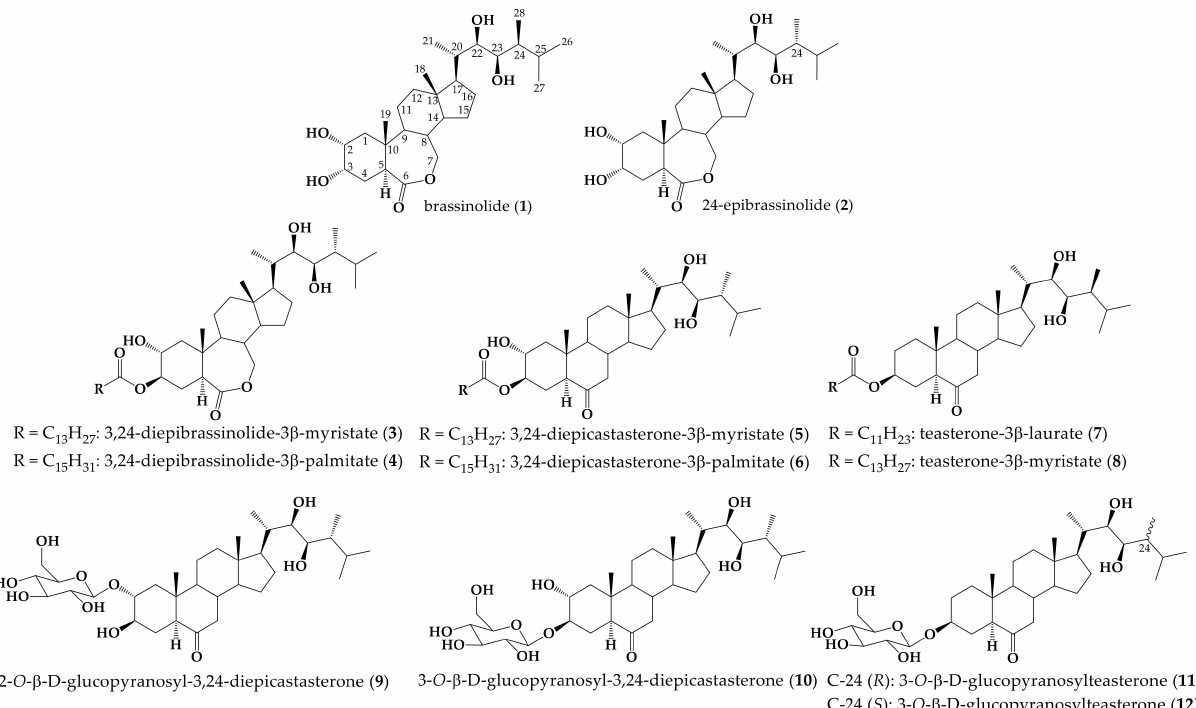
Figure 1. Structure of natural occurring brassinolide ( 1 ), 24-epibrasinolide ( 2 ), metabolites conjugated in C-3 formed by esterification (compounds 3 – 8 ), and metabolites conjugated in C-2 and C-3 formed by glycosylation (compounds 9 – 12 ).